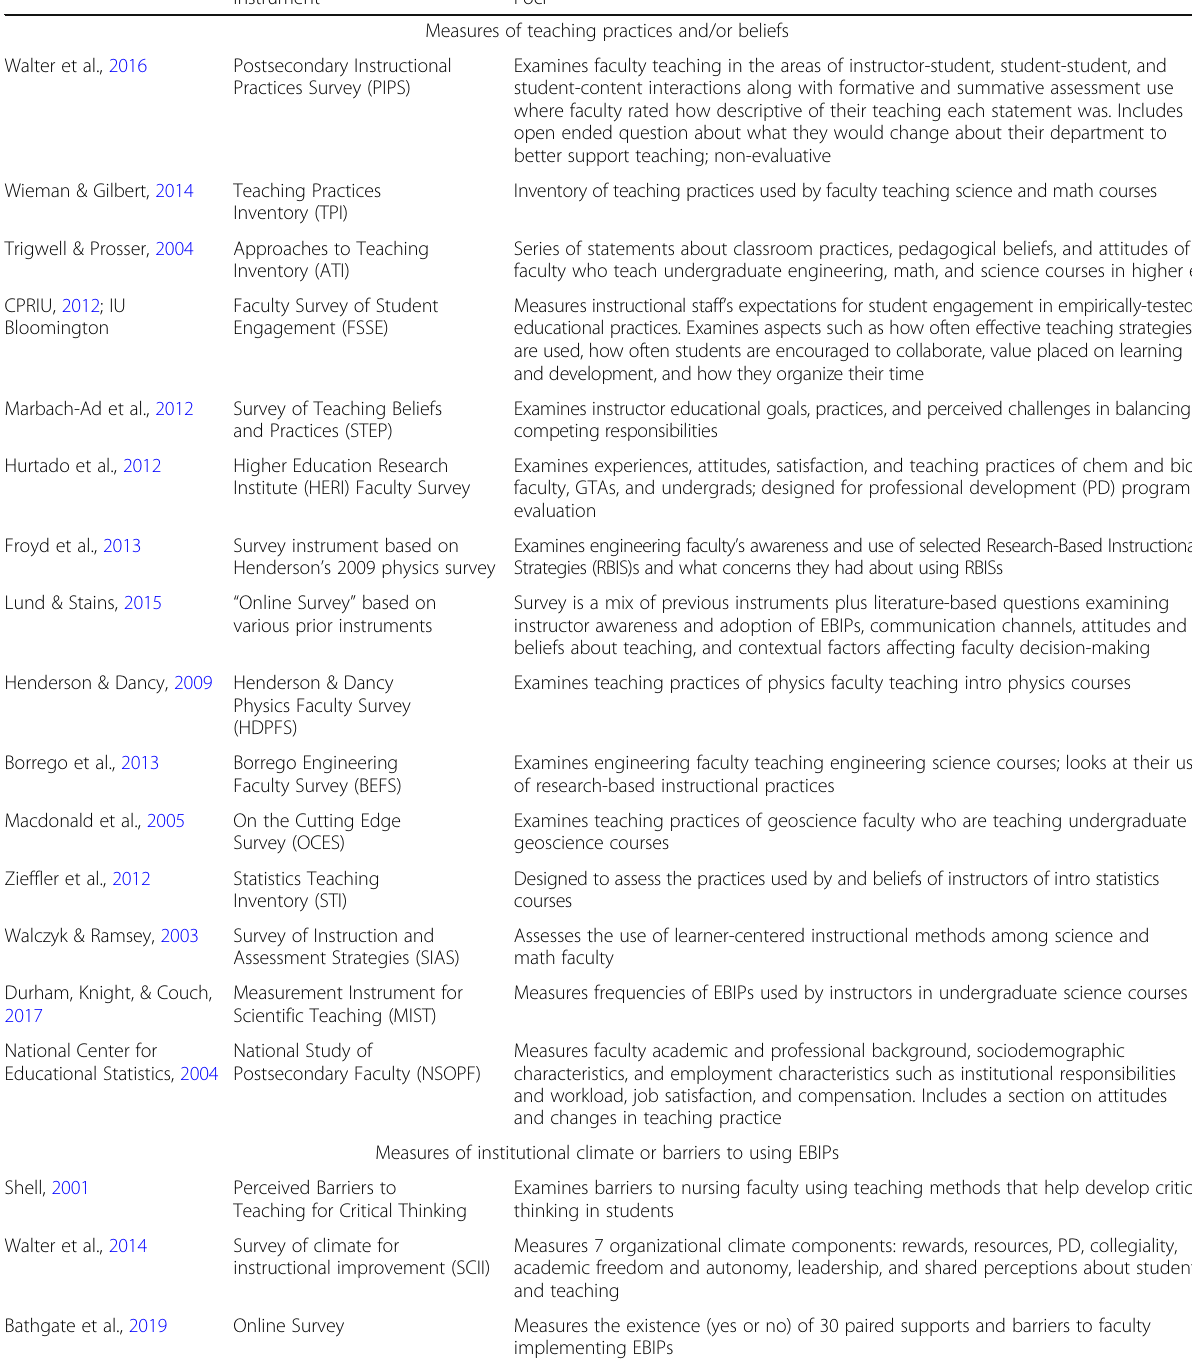
Table 2 List of survey instruments related to faculty use of EBIPs including measures of faculty teaching practices, beliefs, and institutional climate; barriers; and supports to using EBIPs. (Note: list is not intended to be exhaustive but to demonstrate what is being done in these